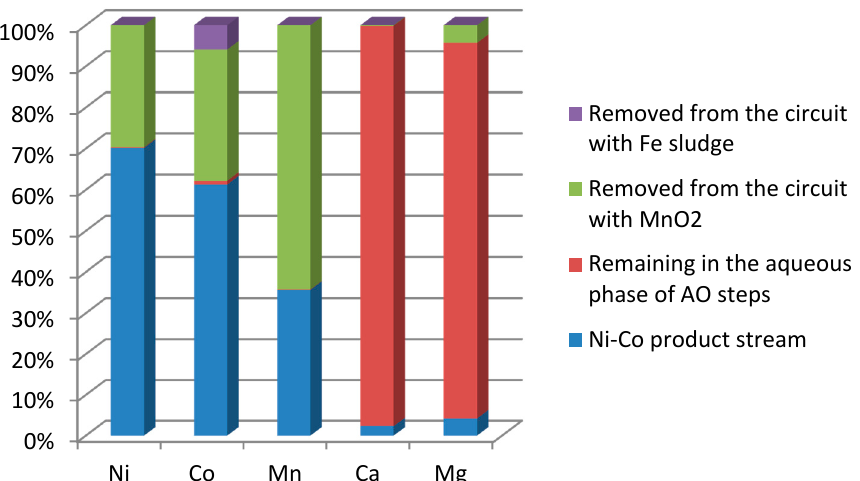
Figure 10. Metal distribution (%) among the streams remaining in the circuit, Fe sludge, MnO 2 precipitates, and final Ni/Co product stream.